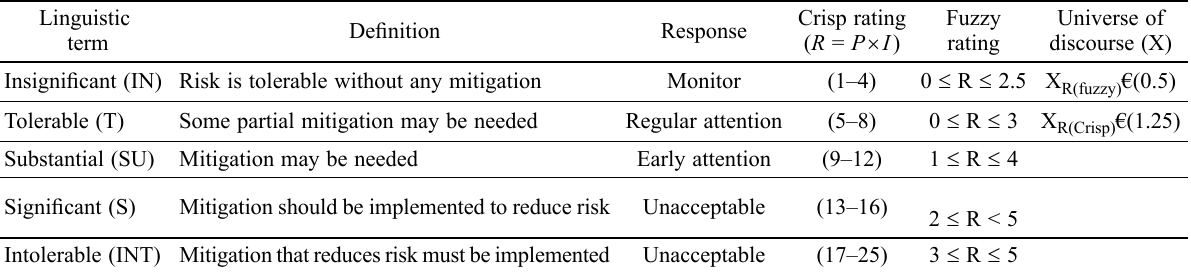
Table 3. Definition of risk levels (Parker 2005; Alidoosti et al.